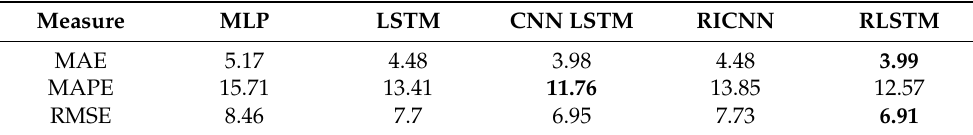
Table 6. The performance of the prediction models for the next-day electricity